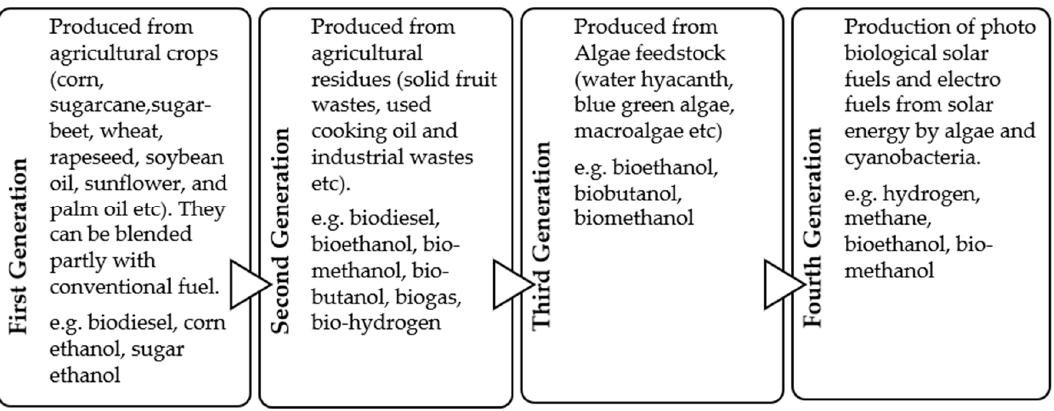
Figure 1. Classification of biofuels (adapted from [11]).